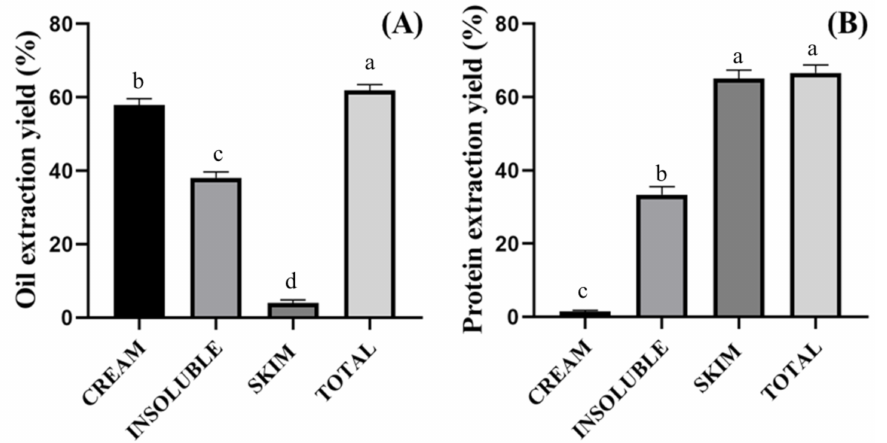
Figure 2. Extraction yields and distribution of oil ( A ) and protein ( B ) among the fractions generated (cream, insoluble, and skim) by the aqueous extraction process of almond flour. Di ff erent letters indicate a significant di ff erence between extraction yields among the fractions within each compound (oil and protein) by the Tukey’s test ( p <